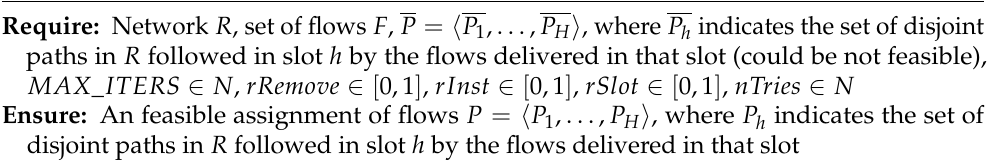
Algorithm 7 Third phase